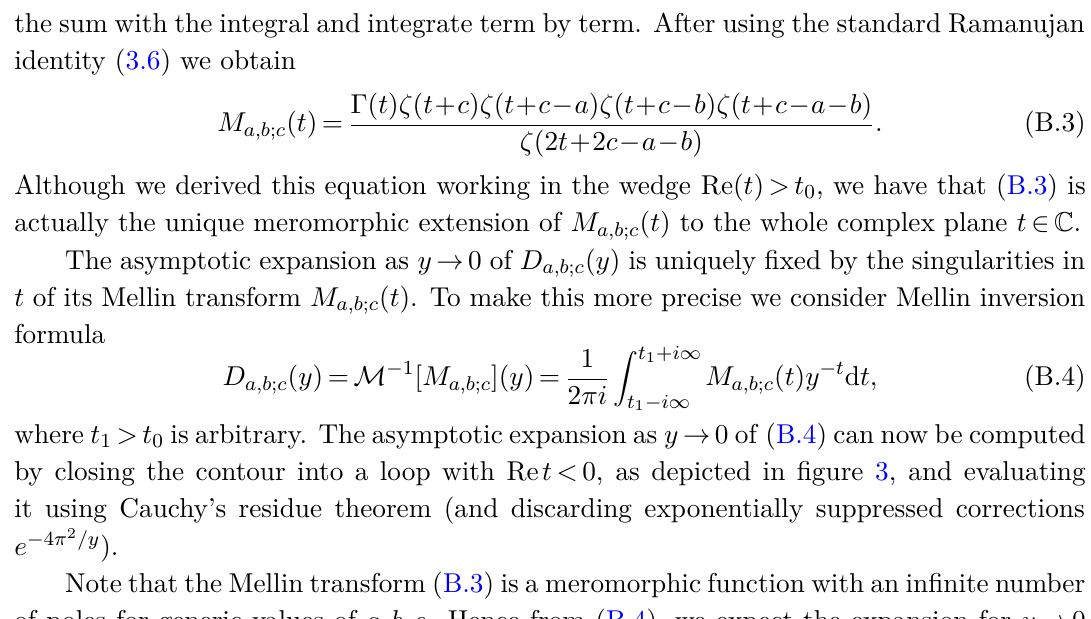
Figure 3 . Deformed t -integration contour for (B.4) and poles structure for the Mellin transform M a,b ; c ( t ) . For a,b,c ∈ C generic, there are two infinite families of poles: t = − n, n ∈ Z ≥ 0 and t = − n − c + a + b , n ∈ Z > 0 , as well as four isolated poles for t ∈ { 1 − c, 1+ a − c, 1+ b − c, 1+ a + b − c } 2